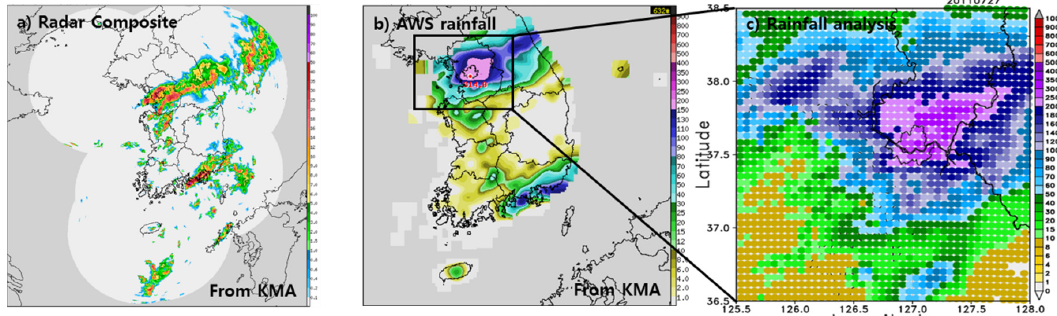
Figure 6. Hourly and daily accumulated rainfall retrieved from ( a ) radar; ( b ) AWS; and ( c ) rainfall analysis on 27 July 2011 by Korea Meteorology Association (KMA).